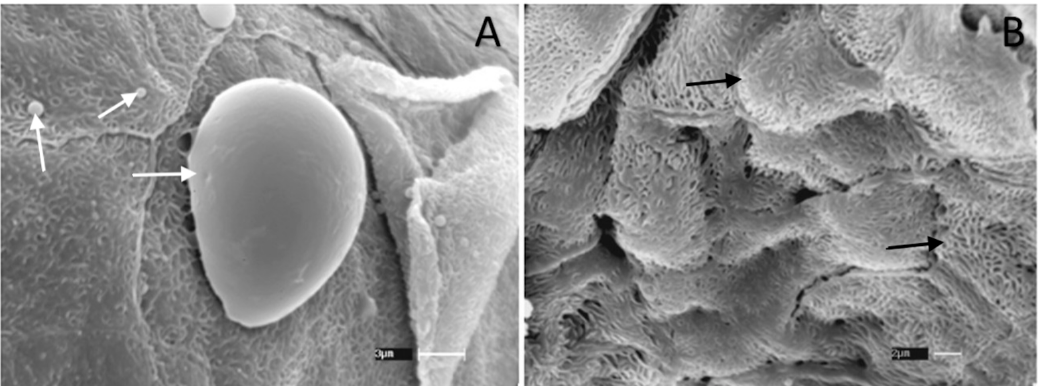
Figure 7. Scanning electron microscopy (SEM) of the vaginal canal from BALB/c mice infected with 3 × 10 5 yeasts of C. albicans ATCC 90028. ( A ) Control group, infected, and treated with neutral cream only. Arrow indicates the presence of C. albicans yeasts on the tissue. Scale bar = 3 µm ( B ) Section of vaginal canal from mice treated with 500 µM of limonene cream. Arrows point to the squamous cells present in the epithelium. Scale bar = 2 µm. Three samples per group were analyzed.